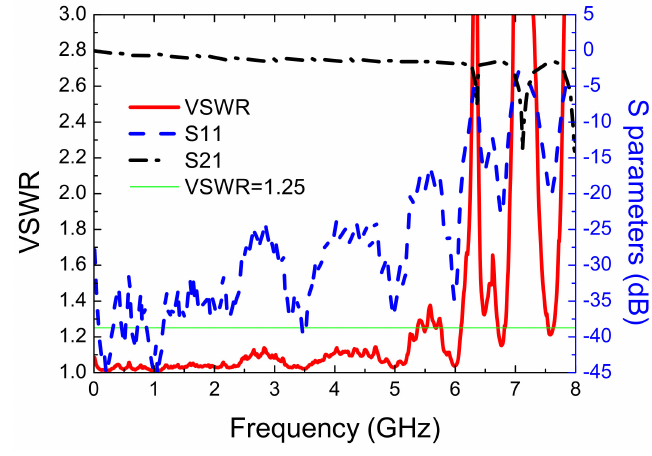
Figure 9. Measurement results of S-parameters and VSWR.